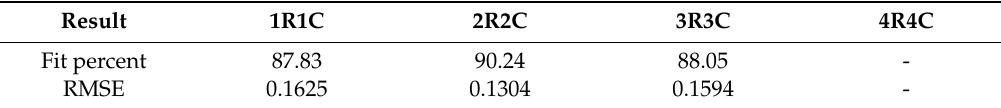
Table 6. Sixty-minute prediction results for experiment A.